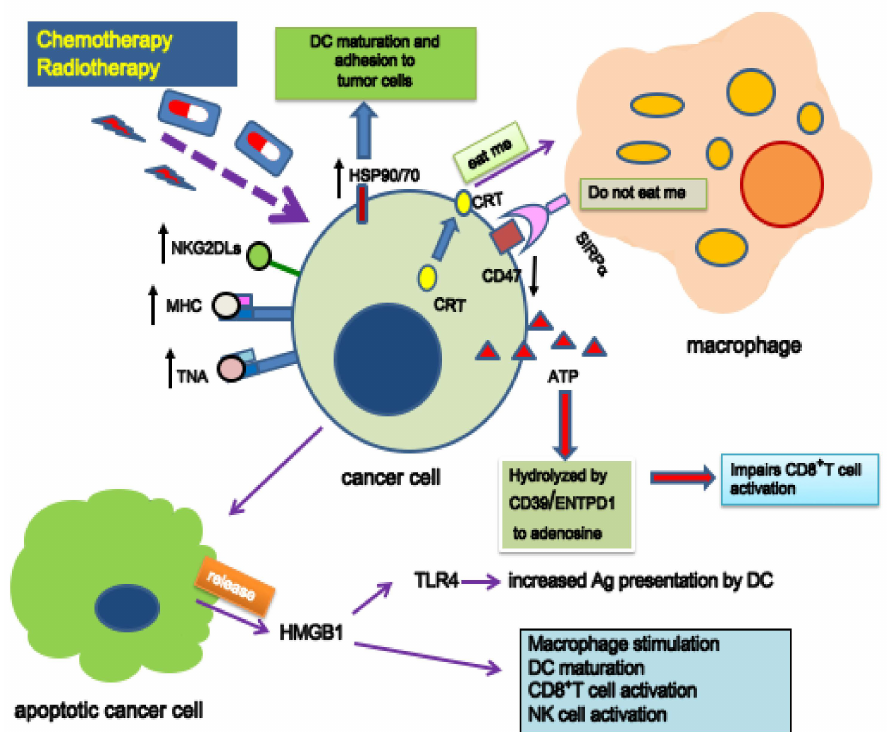
Figure 5. Immunogenic cell death induced by chemotherapy or radiotherapy; possible biochemical patterns. Translocation of calreticulin (CRT) [255] from cytoplasm to tumor cell membrane,